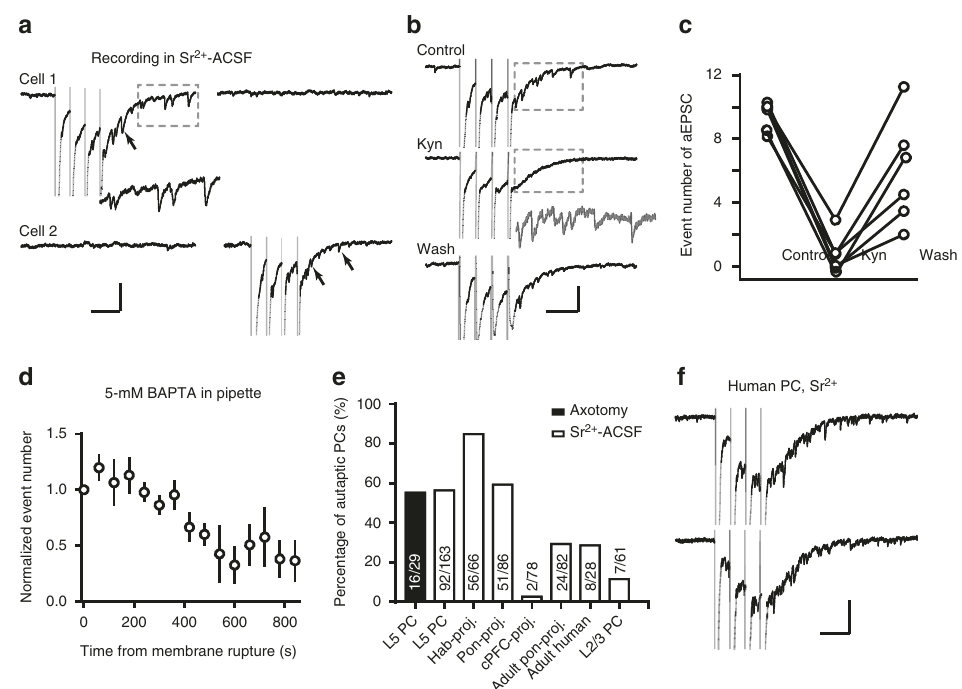
Fig. 2 Selective formation of autapses in neocortical PCs. a Simultaneous recording from two neighboring PCs (<50 μ m apart) in Sr 2 + -ACSF. Action currents (truncated, gray) were followed by delayed asynchronous autaptic currents (arrow). No obvious increase in synaptic events was detected in the unstimulated PC. Inset, an enlarged trace of the boxed area (x2). Scale bars: 100 ms/50 pA. b Bath application of 1.5 mM Kyn blocked the desynchronized aEPSCs. Inset, a result trace from subtraction of the boxed regions (Control — Kyn). Scale bars: 100 ms/50 pA (50 ms/25 pA for inset). c Group data showing the effect of Kyn ( n = 6 cells). d Inclusion of BAPTA (5 mM) in the pipette solution progressively blocked the asynchronous aEPSCs. Data are represented as mean ± SEM. e Percentage of autaptic cells in layer-5 and layer 2/3 PCs, and those projecting to the contralateral PFC (cPFC-proj.) or subcortically to pons (Pon-proj.) and habenula (Hab-proj.). For injection of retrograde beads at pons and habenula, see Supplementary Figure 2. f Example traces from a layer-5 PC in human cortical slice (scale bars: 100 ms/100 pA). Also see Supplementary Figure